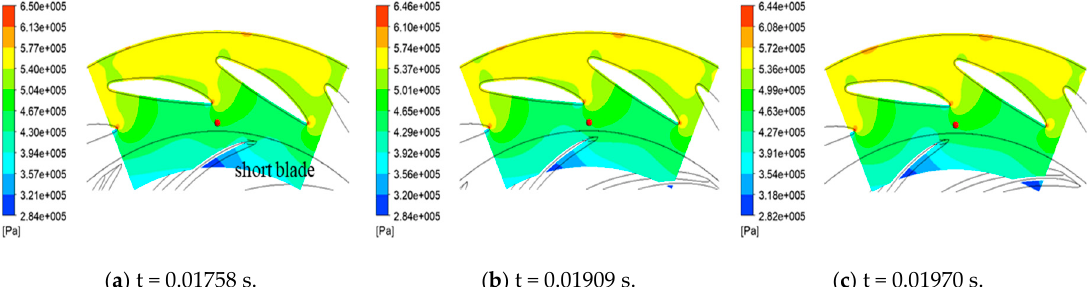
Figure 14. Pressure distribution of GR001 at different times at 1.0 Q d .